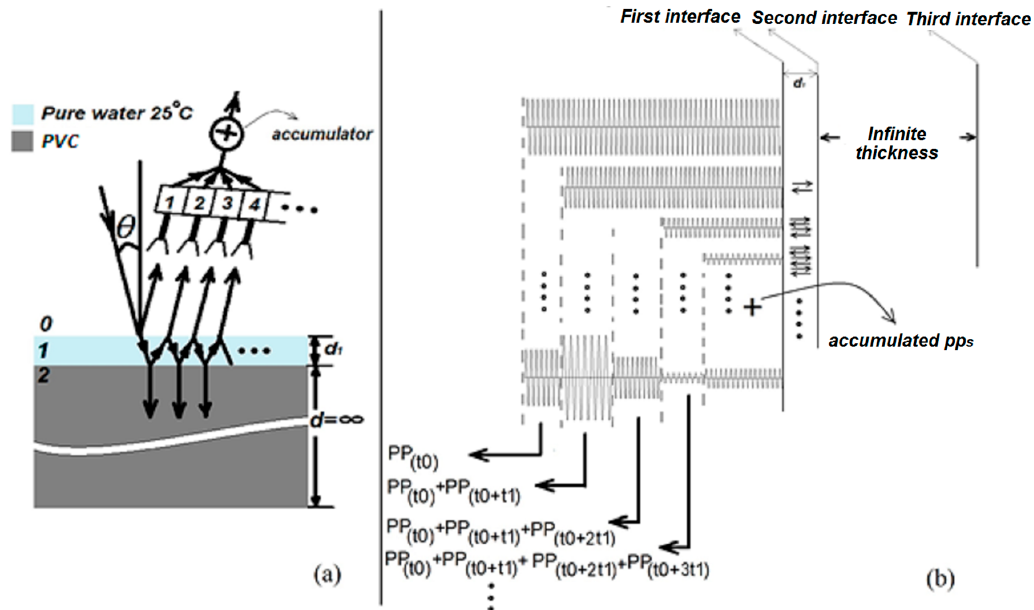
Figure 2. ( a ) Schematic illustration of the propagation multi-pathways of an EMW incident on a double-layer structure and partially bouncing forth and back between the various interfaces. ( b ) Schematic illustration of the time evolution of the EMW being reflected on the various interfaces of the double-layer structure with θ = 0. The nose of the illustrated reflected wave hits the detector after the round-trip time.